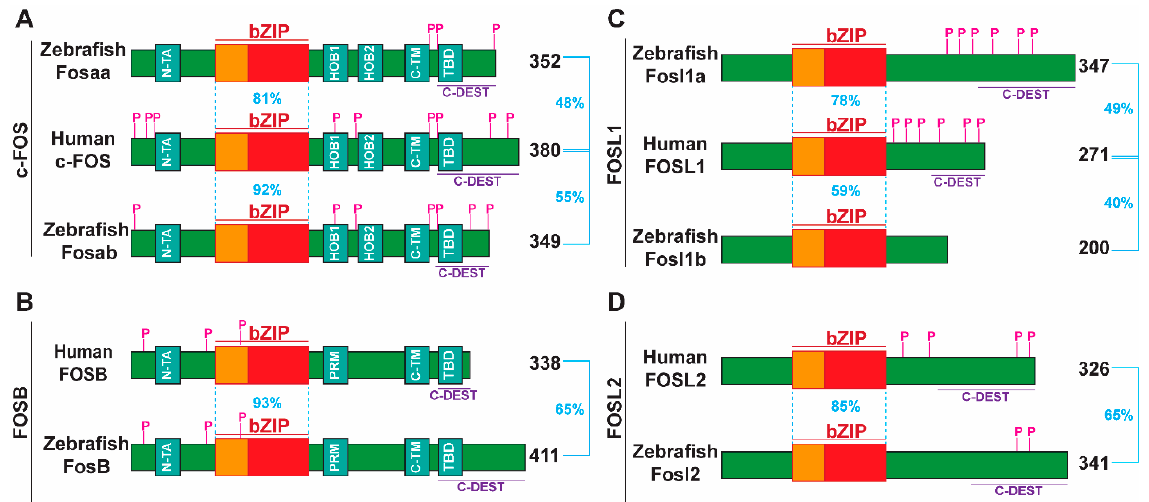
Figure 3. Schematic representation of human and zebrafish FOS proteins. Depicted are human and zebrafish sequences related to c-FOS ( A ), FOSB ( B ), FOSL1 ( C ), and FOSL2 ( D ). Functional regions indicated are the basic leucine zipper (bZIP) including the basic region for DNA interaction (orange box) and leucine zipper for dimerization (red box), N-terminal transactivation domain (N-TA), ho- mology box one and two (HOB1, HOB2), proline-rich motif (PRM), C-terminal transactivation motif (C-TM), transactivation domain (TBD), and destabiliser region (C-DEST). Previously characterised phosphorylation (P) sites curated in the Phosphosite database (phosphosite.org) are indicated. The percentage identity within the bZIP domain and overall protein are indicated by blue dotted or solid lines and text, with the protein length indicated on the left in black text.